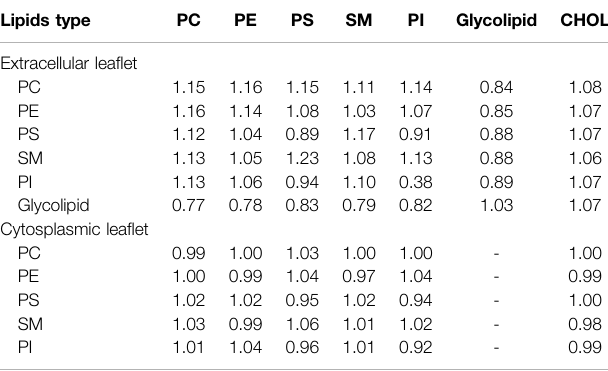
TABLE 3 | Lipd enrichment factor in myelin bilayer. Number of lipids within 1.5 nm of a reference lipid type are reported for the extracellular and cytoplasmic lea fl et separately. Standard errors are less than 0.1